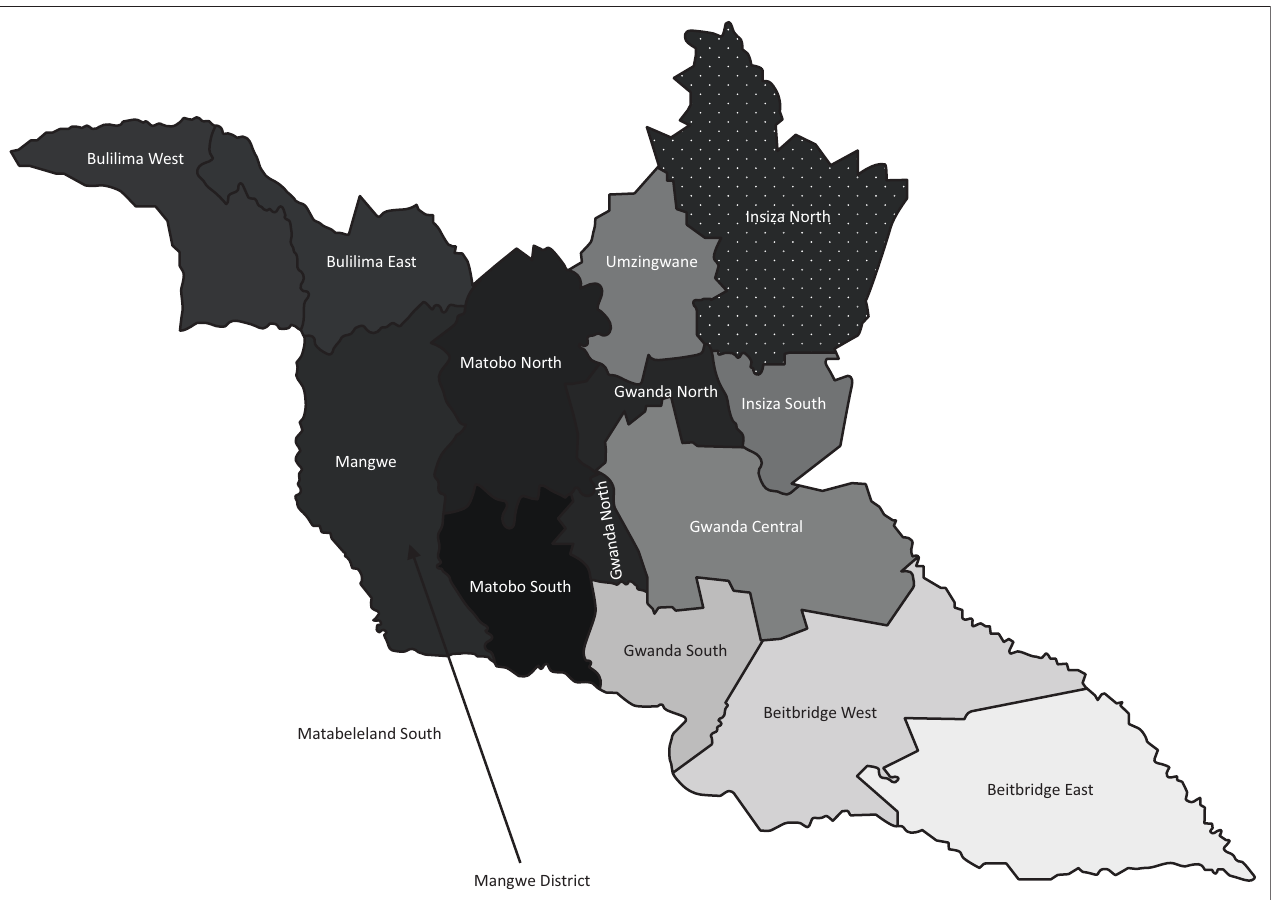
FIGURE 1: Position of Mangwe District in Matabeleland South Province,